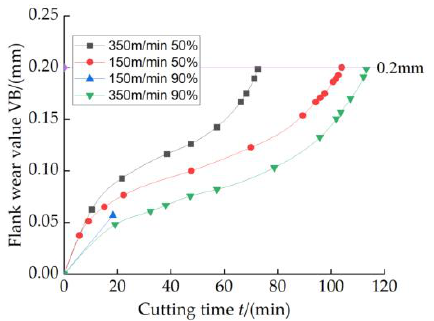
Figure 6. Influence of CBN content on tool wear.